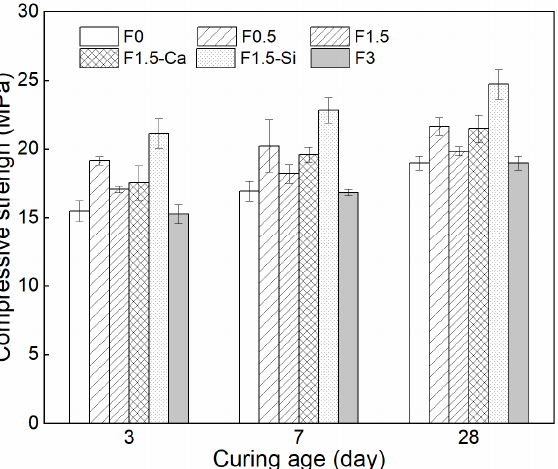
Figure 13. Compressive strength of LWAC with coir fibers of various contents and different treat- ments measured at 3, 7, and 28 days. measured at 3, 7, and 28